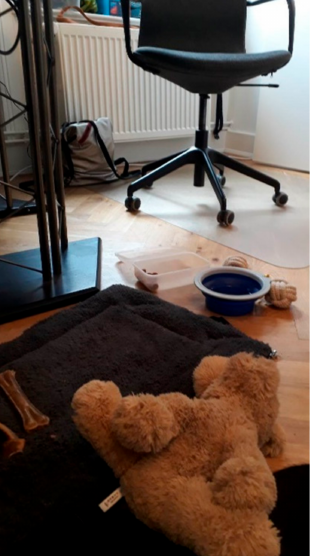
Figure 1. Dog’s place in the